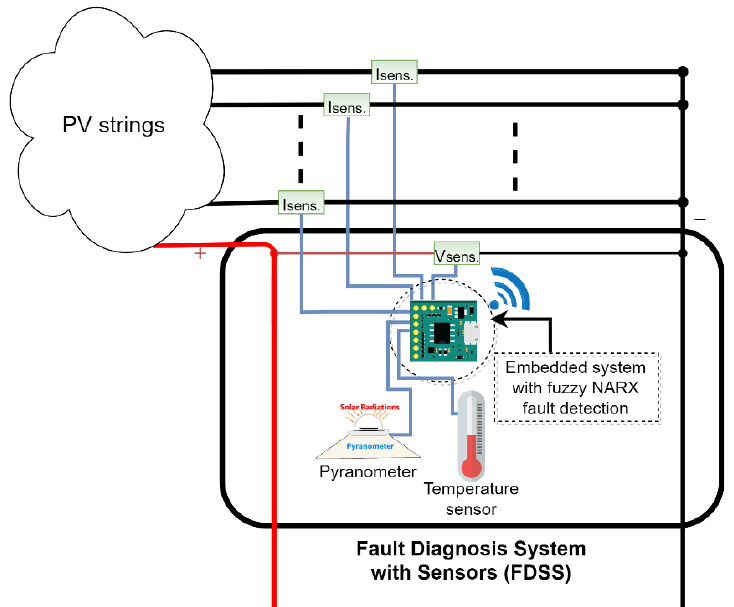
Figure 3. Fault diagnosis system with sensors (FDSS) connected to more than one PV string.